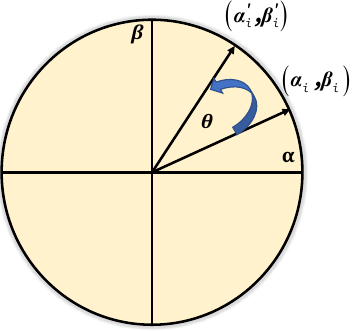
Figure 1. The process of updating the state of a quantum